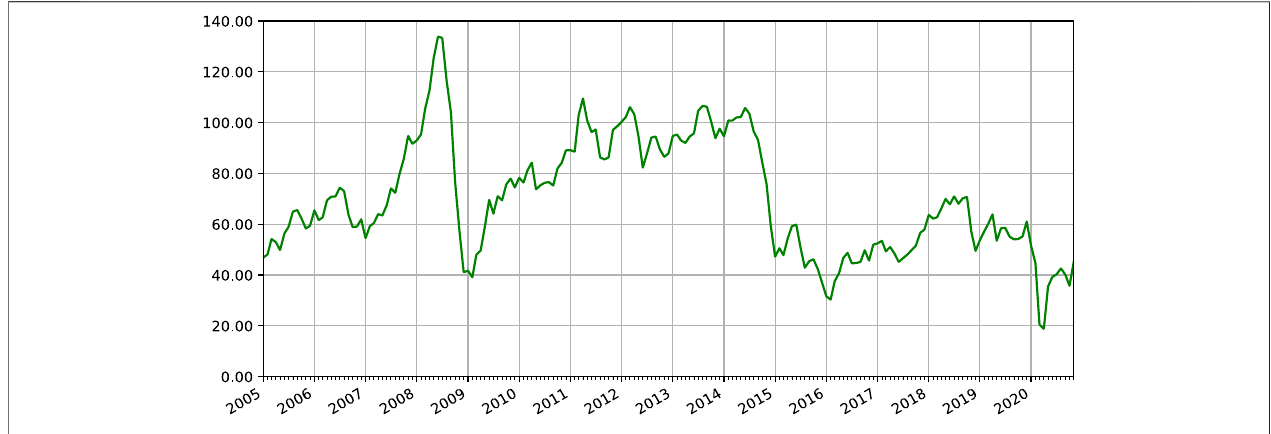
FIGURE 1 | Crude oil West Texas Intermediate (WTI), January 2005 – December